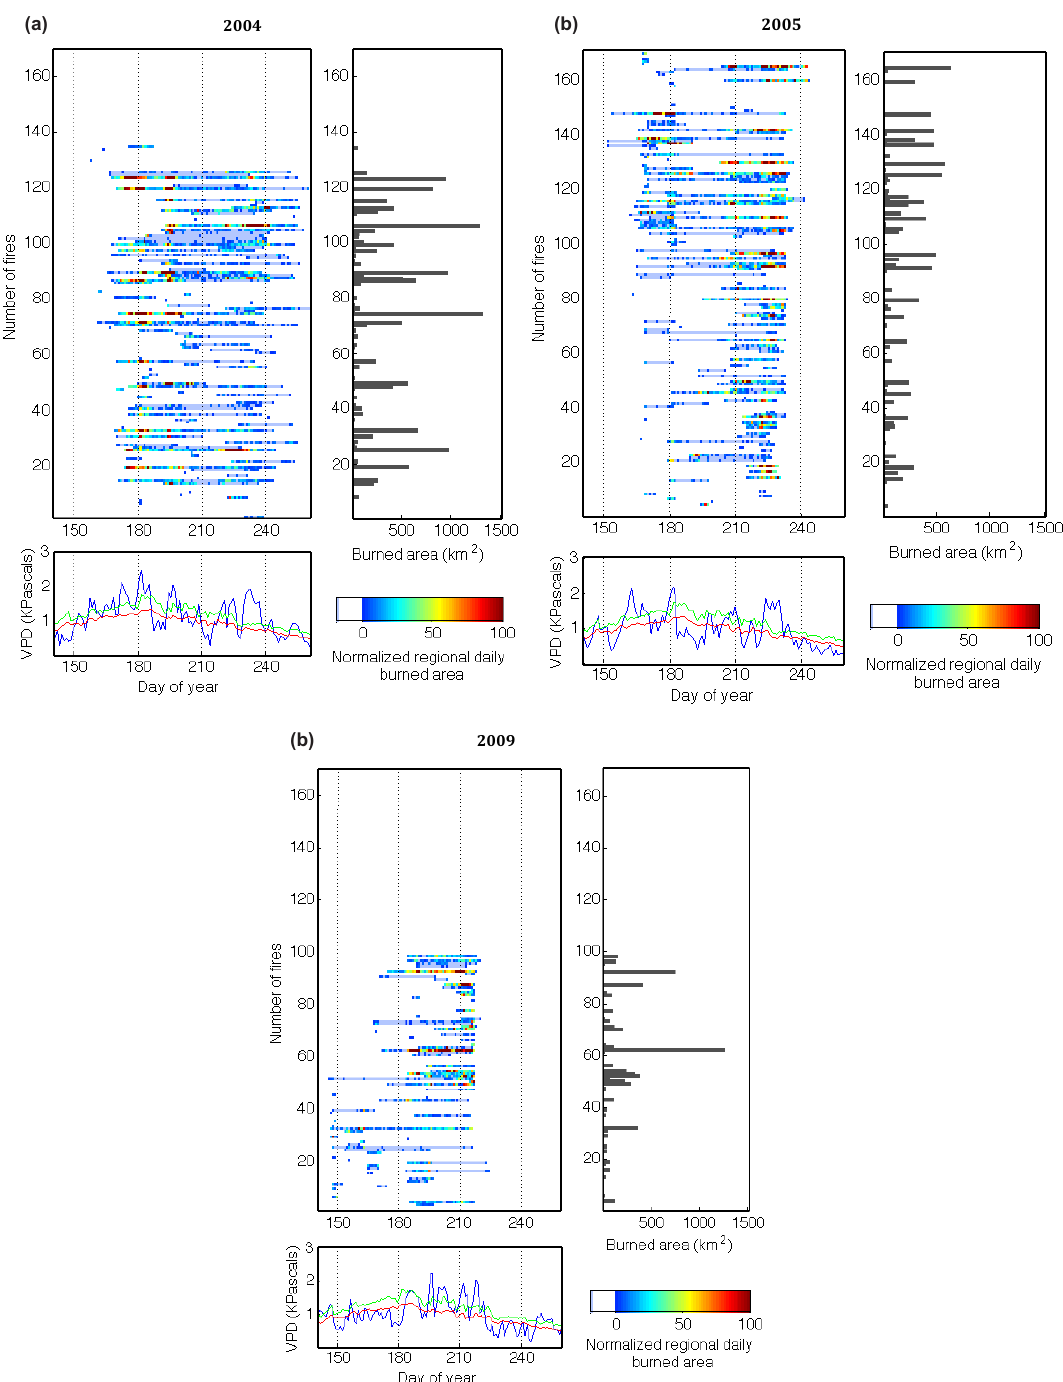
Figure 6. Top plate: length and daily burned area of individual fires in 2004, 2005 and 2009. Each line represents a recorded fire event in each year. Fires are organized from north (top) to south (bottom) within the study domain. The color bar represents daily burned area, with values normalized by annual regional daily burned area values between 0 and 100. Light blue (color code − 20) represents days between ignition and extinction in which burned area was not registered. Bottom plate: daily VPD values averaged for interior Alaska (blue), 1979–2011 daily VPD average (red) and 75th percentile values in the period 1979–2011 (green). Interior Alaska was defined by the longitudes 142 ◦ –154 ◦ West and latitudes 63.5 ◦ –67.5 ◦ North. The horizontal axes in both plates represent the day of the